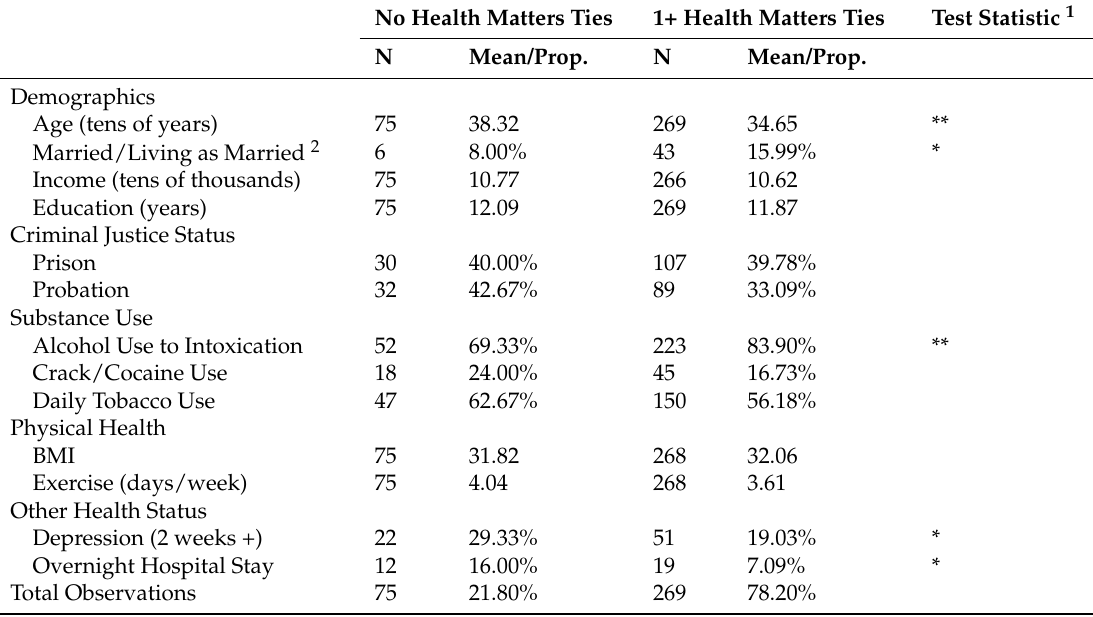
Table 2. Differences in independent predictors for participants reporting no health matters network ties to those with one or more